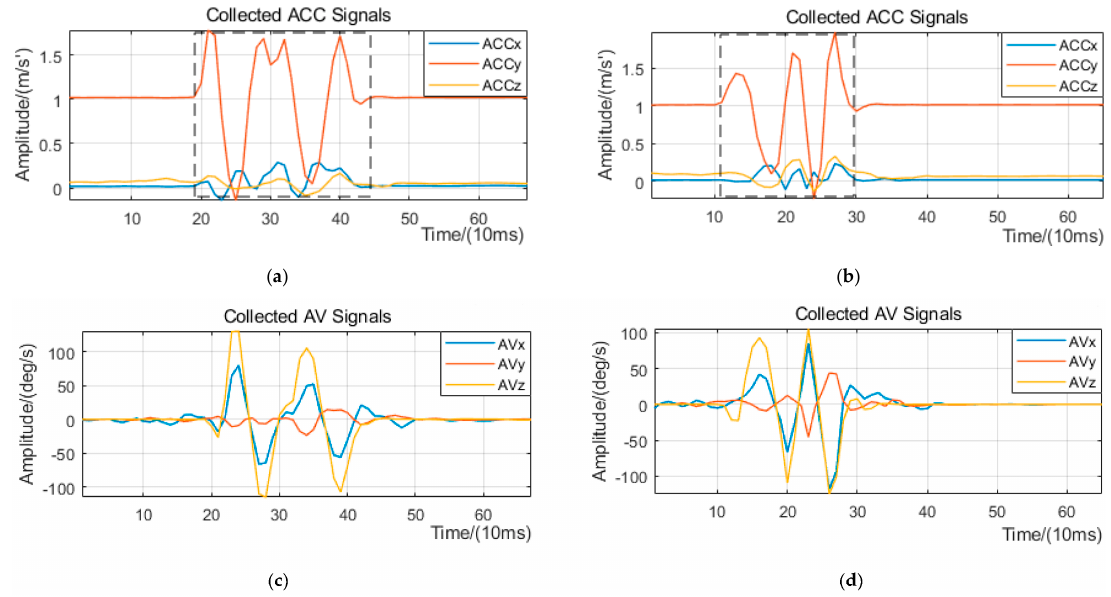
Figure 7. Collected raw signals of wave-shape movement at the two speeds. ( a ) Acceleration (ACC) signals of VWM, ( b ) ACC signals of fVWM, ( c ) Angular velocity (AV) signals of VWM, and ( d ) AV signals of fVWM.